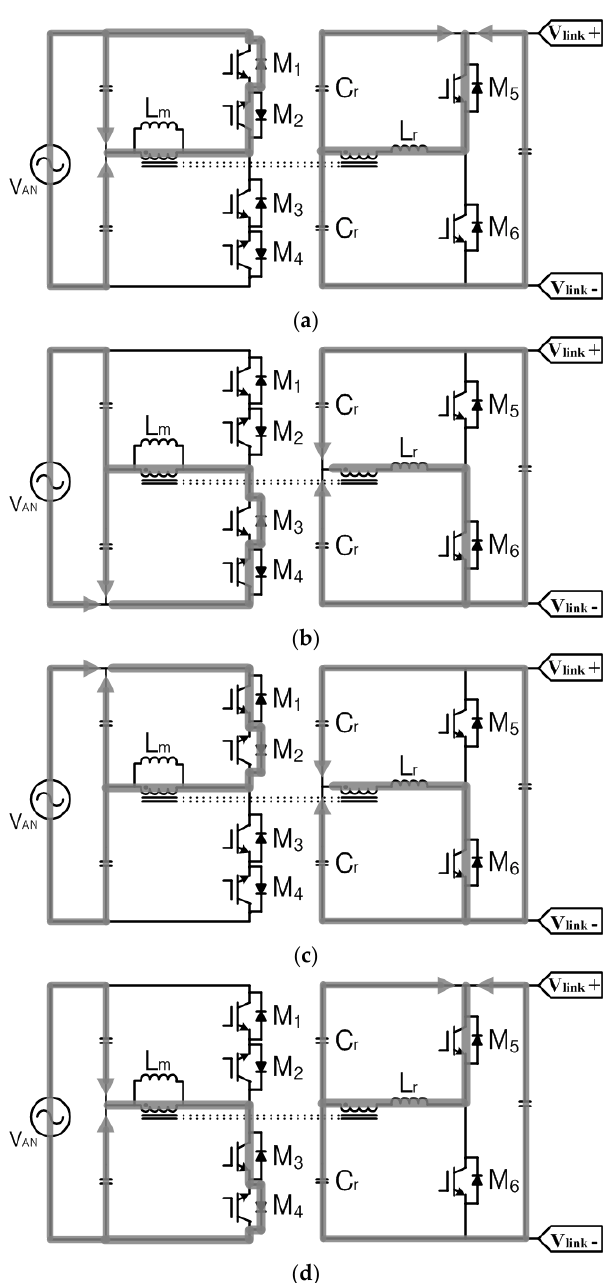
Figure 5. Current path of AC–DC converter in reverse power flow: ( a ) Mode 5: positive input voltage (M1: on, M2: on, M5: on); ( b ) Mode 6: positive input voltage (M3: on, M4: on, M6: on); ( c ) Mode 7: negative input voltage (M1: on, M2: on, M6: on); ( d ) Mode 8: negative input voltage (M3: on, M4: on, M5: on).